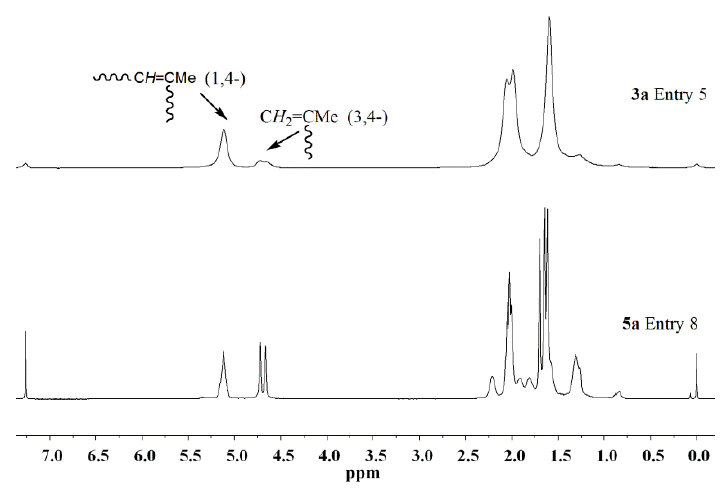
Figure 3. 1 H NMR spectra of polyisoprenes obtained by Fe(II) catalyst.